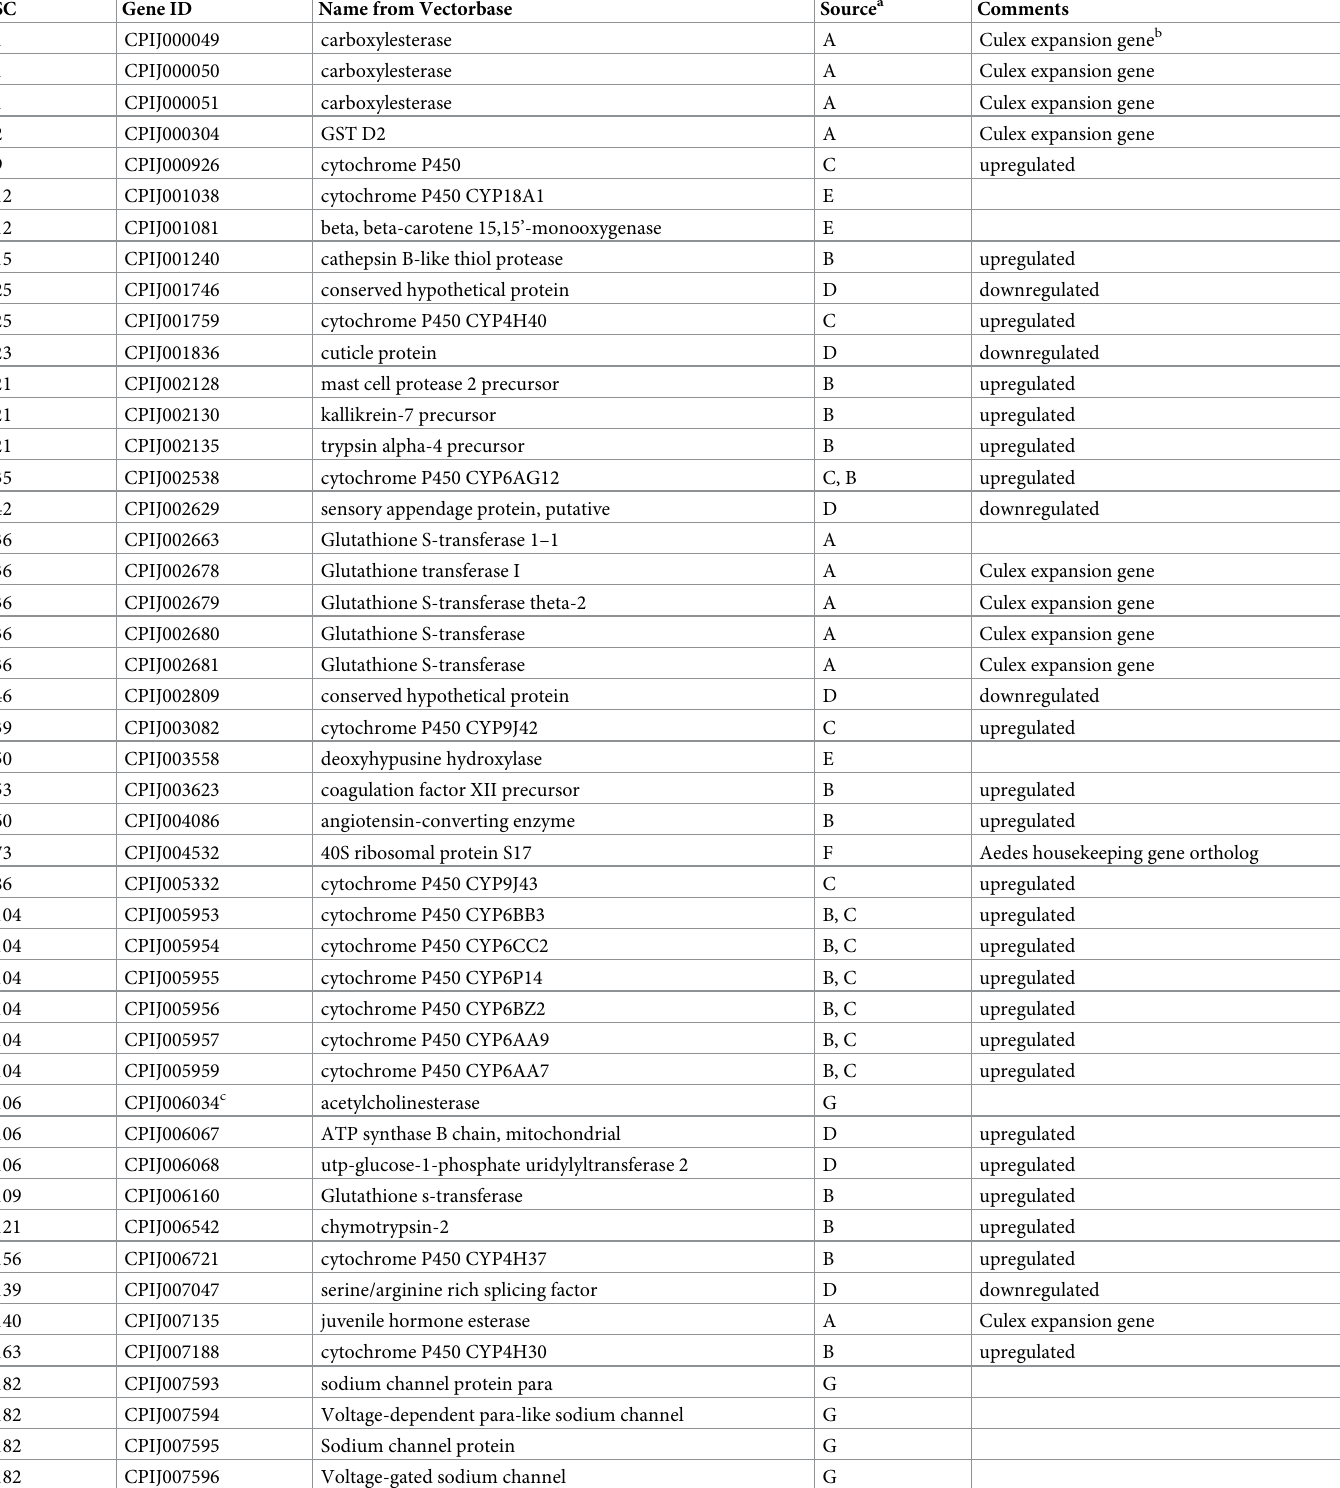
Table 2. Names and sources of Culex quinquefasciatus genes included in the targeted sequencing